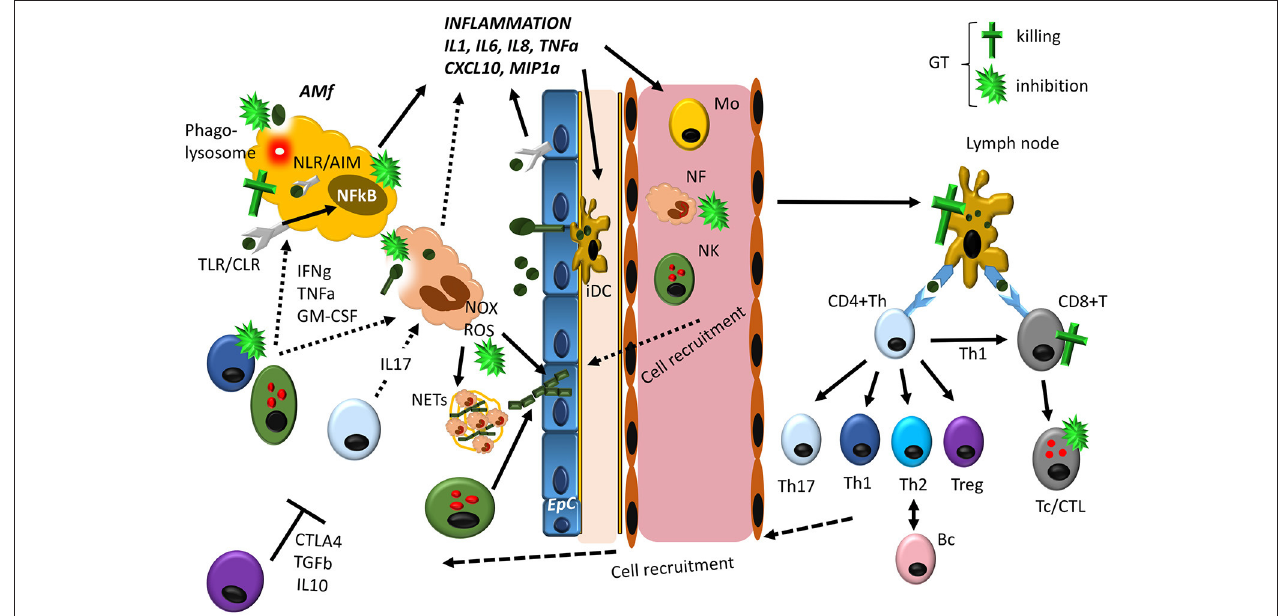
FIGURE 1 | Overview of the lung immune response against Aspergillus, indicating the main targets for GT-induced immunosuppression. Resident alveolar macrophages (AM) and epithelial cells (EpC) interact with germinating Aspergillus spores in the lung by different PRRs (mainly TLRs, C-type lectin receptors/CLRs and NLRs), activating the NFkB transcription factor mainly responsible of the synthesis of inflammatory cytokines and chemokines. In addition, AM are able to directly kill phagocytosed spores in phagolysosomes. In response to inflammation, several cells are attracted to the infected site and activated like neutrophils (NF), monocytes (Mo) and NK cells. NF are the first cells extravasating from circulation to the infection site, where they phagocytose and kill Aspergillus conidia and enhance the inflammatory response. In addition, they are able to kill hyphae generated from conidia that have avoided AM, by releasing ROS produced by NADPH oxidase (Nox) as well as to trap them in structures released when neutrophils die known as NETs. Other cells like circulating Mo and NK cells also contribute to Aspergillus clearance, directly or by releasing cytokines that enhance anti-fungal activity of AM and NF. Meanwhile the innate immune response tries to eliminate Aspergillus conidia and hyphae, interstitial immature Dendritic Cells (iDC) phagocytose conidia and hyphae and migrate to lymph nodes, where fully mature DCs present these antigens to CD4 + Th and CD8 + T cells. Here depending on the nature of the Ag presented and the cytokines produced by DC, Th cells differentiate into the different subsets, CD8 + T cells are activated generating cytotoxic T cells (Tc/CTL) and B cells transformed in antibody producing plasma cells. All these cells migrate to the site of infection and contribute to the elimination of the fungus (Th1 and Th17 cells) and to avoid an exacerbated inflammatory response (Treg cells), by expressing cytokines and ligands with different activities. As described in the text GT can interfere with host immune response at different levels. The most pronounced effect seems to be related with its ability to block the inflammatory immune response of macrophages by direct killing or by inhibiting NFkB as well as phagocytosis. In addition, GT is able to kill epithelial cells, and, thus, the fungus could potentially use GT to completely inhibit the generation of the immune response. However, it should be noted that GT is only produced at the hyphae level, and, thus, AM and EpC will be able to activate the immune response, before hyphae are produced. At this stage NFs are critical to eliminate hyphae and, GT has been described as a potent inhibitor of NOX as well as phagocytosis. Finally, GT would inhibit the adaptive immune response at different levels, contributing to host colonization. From this scheme, it seems clear that the contribution of GT to Aspergillus infection will depend on the balance between host immune activity and hyphae